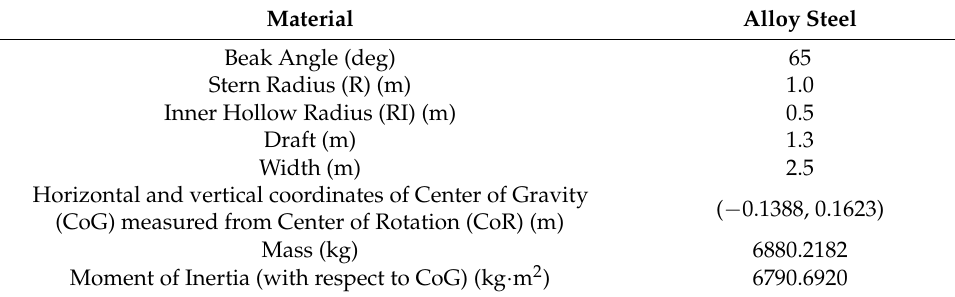
Table 4. Specification of an asymmetric WEC (1/2